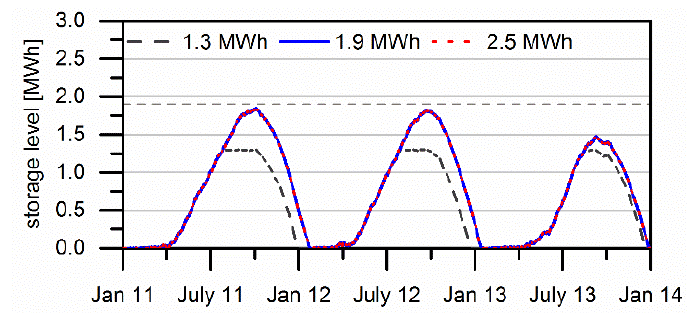
Figure 13. Storage level over the consideration period of 3 years.